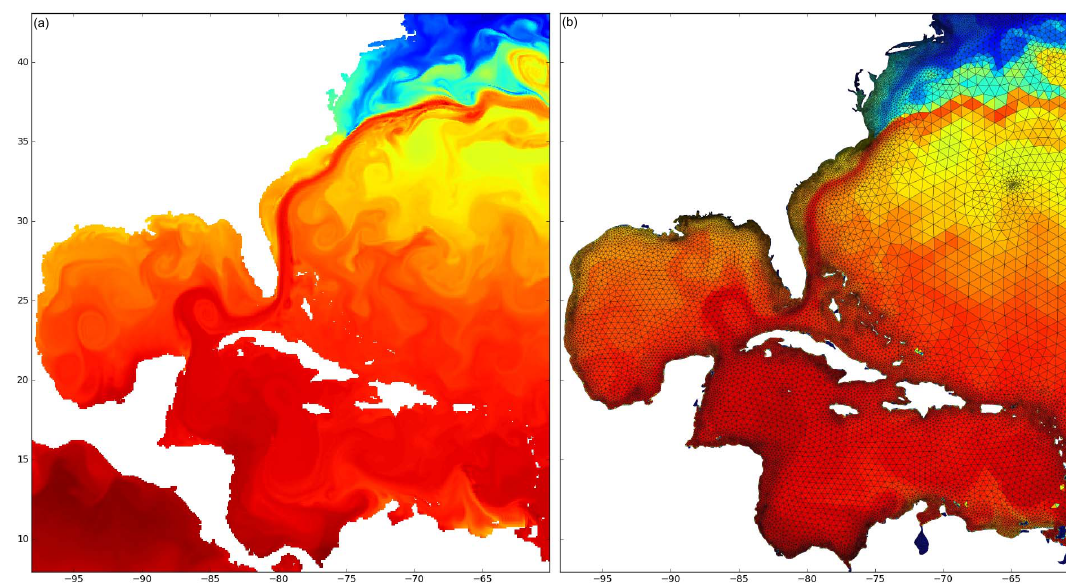
Figure 8. Result of a remapping performed by the CDO remapper using the OMUSE interface. A sea surface temperature field is remapped from POP using a 0.1 ◦ tripole grid (a) to the elements of an unstructured grid (b)